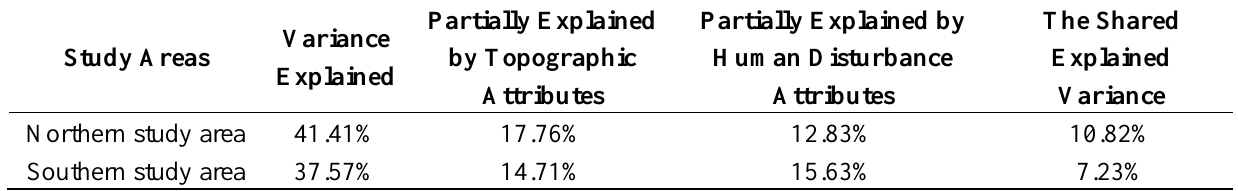
Table 9. Decomposed explained variance in vegetation